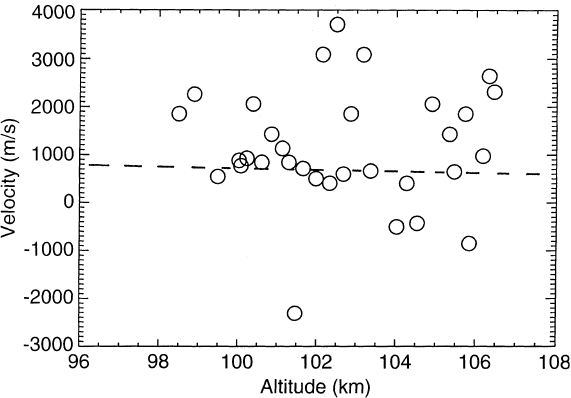
Fig. 8. Propagation velocity component in the direction along the rocket axis obtained from the maximum time-delay of cross- correlation of the signals U 5 and U 6 , see also Figs. 6 and 7. The results are shown as a function of altitude for upleg conditions. The dashed line shows the slowly varying vertical component of the rocket velocity. Points clustering around this velocity may indicate the presence of structures in the plasma density, which, in the rocket frame, will appear as propagating backwards with the rocket speed. Also points with forward propagation velocity can be expected, due to detection uncertainty when we observe essentially plane structures propagating in a direction perpendicular to